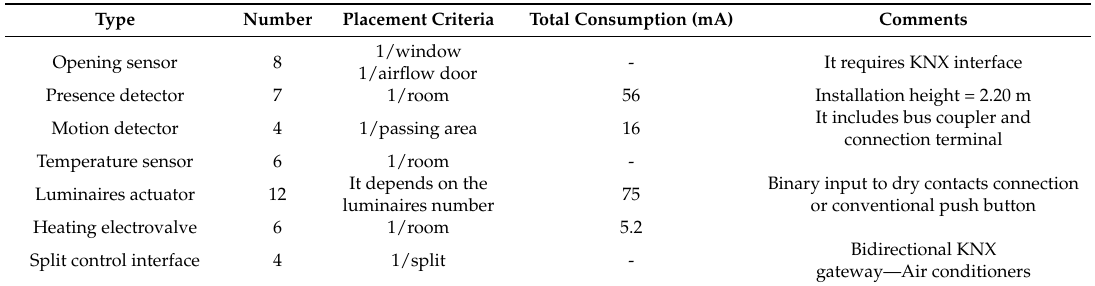
Table 1. Installed sensors and actuators in basic home automation system.